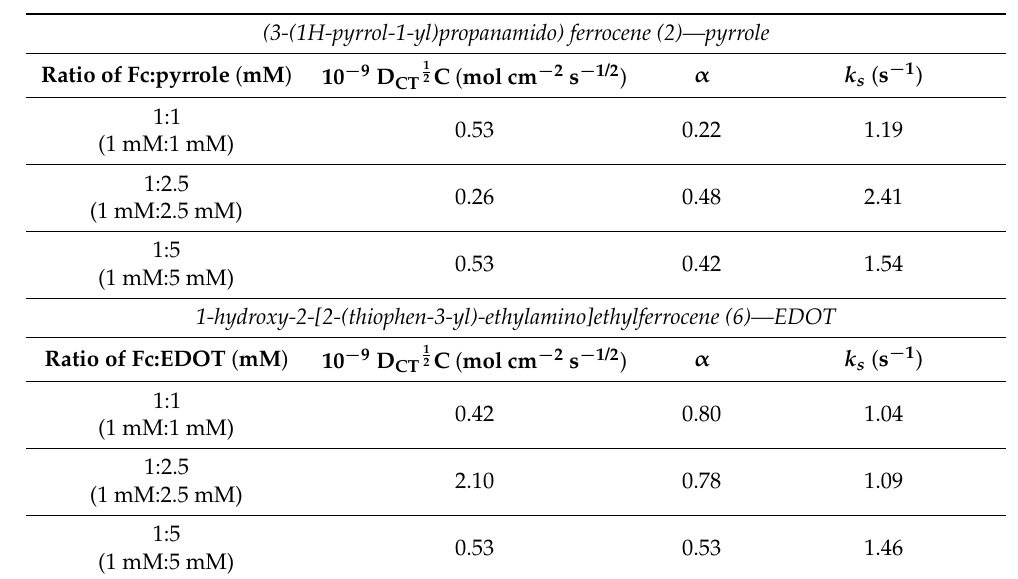
Table 2. Data on D CT 1 2 C, α and k s of the films of (3-(1 H -pyrrol-1-yl)propanamido) ferrocene ( 2 ) and pyrrole and 1-hydroxy-2-[2-(thiophen-3-yl)-ethylamino]ethylferrocene ( 6 ) with